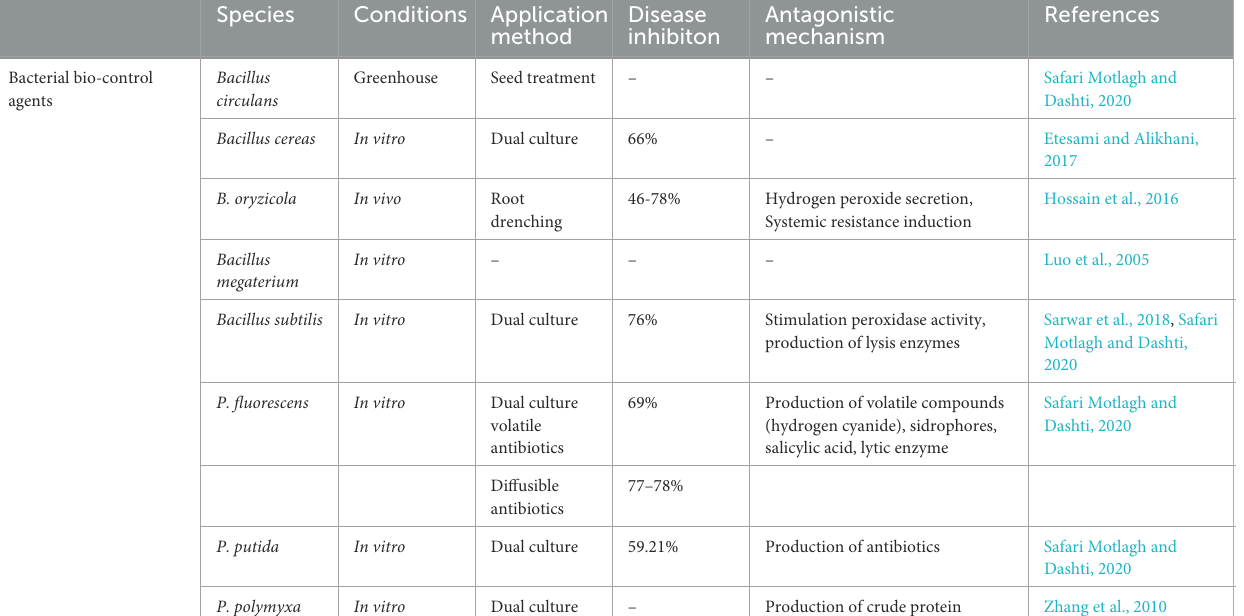
TABLE 1 Bacterial bio-control agents used against the bakanae disease of